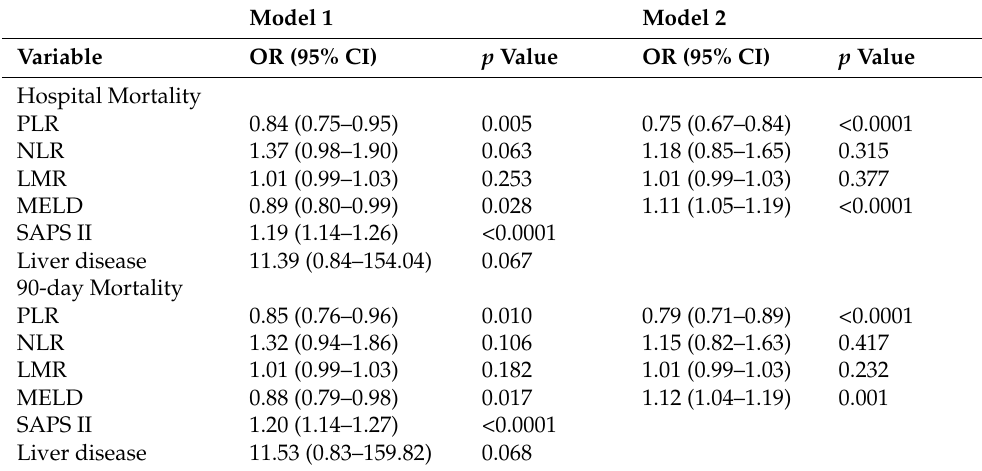
Table 5. Association between PLR with prognosis of newborn